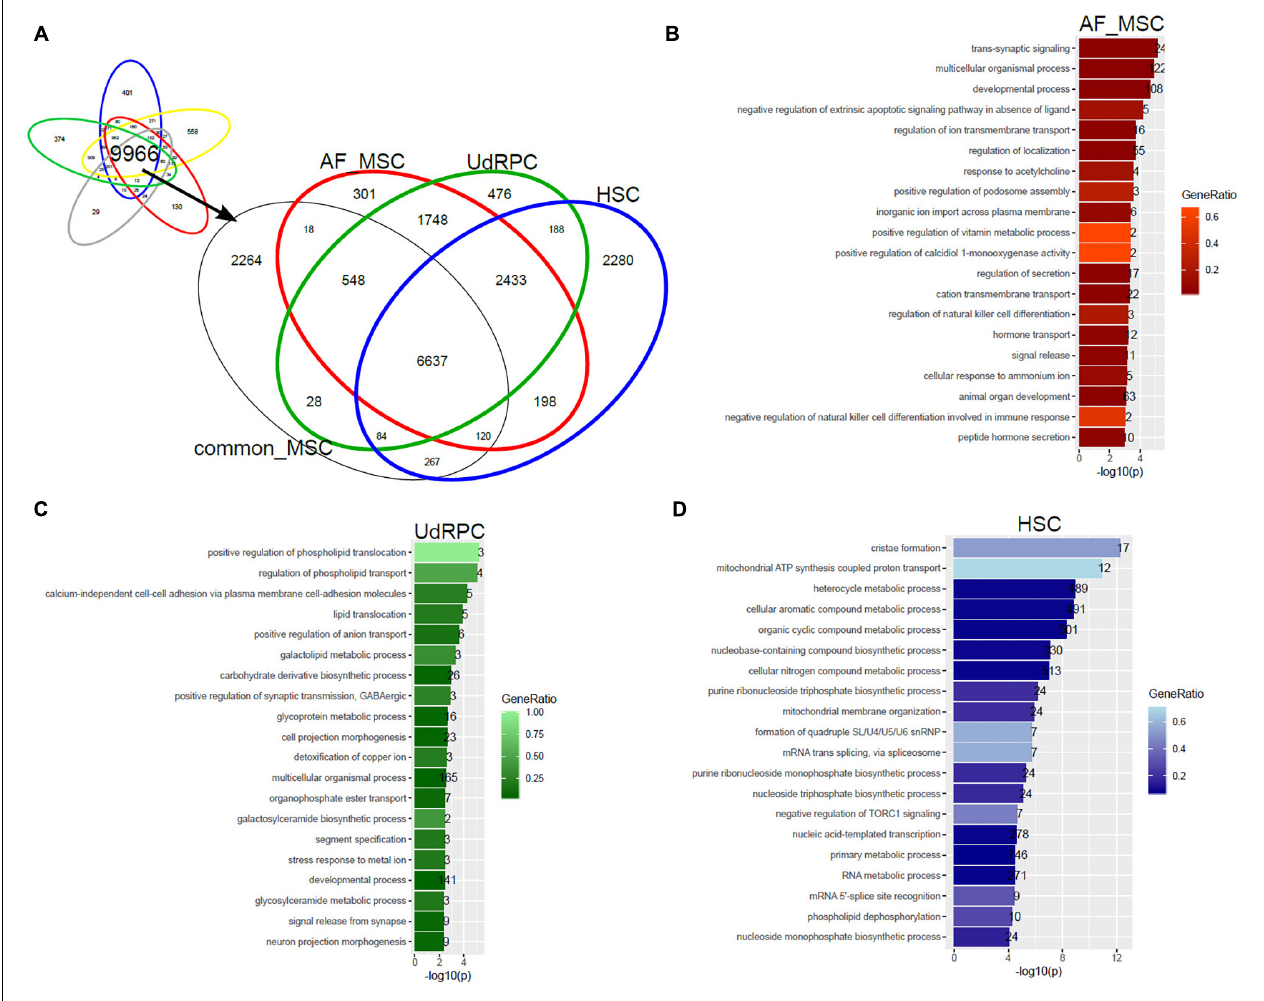
FIGURE 4 | Tissue of origin determines heterogeneity of amniotic-fluid-derived MSCs (AF-MSCs), urine-derived renal progenitor cells (UdRPCs), and hepatic stellate cells (HSCs). (A) Genes expressed in common in MSCs on the Illumina platform (9966 genes) were compared with AF-MSCs, UdRPCs, and HSCs. Subsets of genes exclusively expressed in AF-MSCs (301 genes in A ),UdRPCs (476), and HSCs (2280) were analyzed for over-representation of GO terms. (B) Most significantly over-represented GO terms in AF-MSCs include developmental and signaling processes which may be considered characteristic for embryonic development. (C) Most significantly over-represented GO terms in UdRPCs include lipid transport and detoxification pointing at renal properties. (D) Most significantly over-represented GO terms in HSCs include metabolic, cristae and mitochondrial processes pointing characterizing